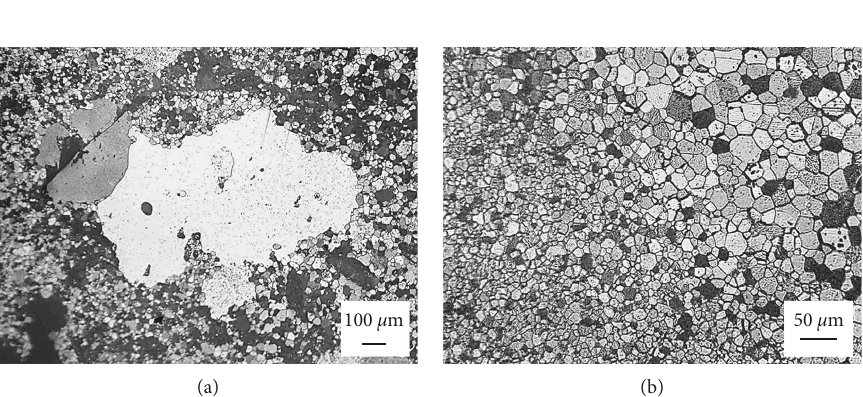
Figure 6: Perpendicular and parallel cross-sectional microstructures of the ZnO ceramics compacted by MPC and sintered at 1300 ° C for 2h recorded from (a) central region and (b) outer region.